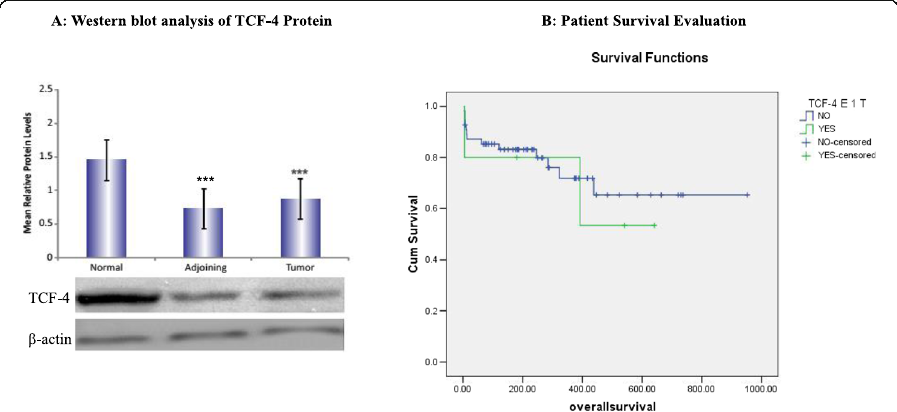
Fig. 5 a Western blot analysis of TCF-4 protein. Western blot analysis of TCF-4 protein in normal, adjoining and tumor tissues from CRC Patients. Bar diagram showing densitometric analysis of the TCF-4 protein normalized with β -actin protein in normal, adjoining and tumor tissues. Protein levels of TCF-4 were lower in adjoining and tumor tissues of CRC patients compared to normal tissue. Western blot of β -actin as a loading control. *** p < 0.001 compared to normal tissue. A total of 20 cases each of tumor, adjoining and normal mucosa were analyzed for protein expression by western blotting studies. b Patient survival evaluation. Kaplan-Meier survival curves were constructed and log rank analysis revealed that TCF-4 exon 1 gene mutations had no correlation with overall survival or disease-free survival of the patients ( p >